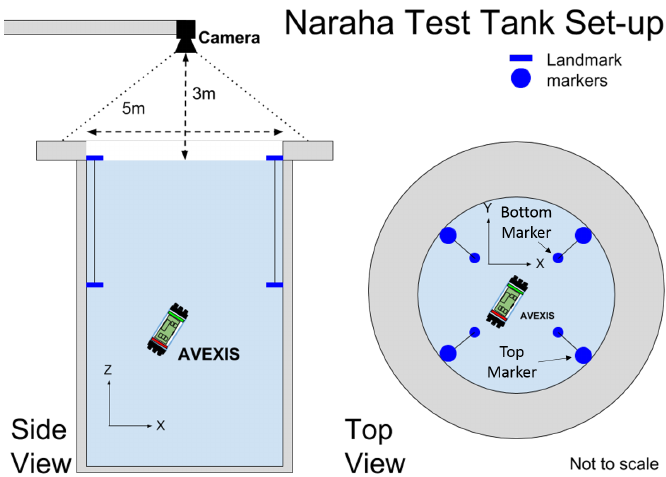
Figure 6. Example deployment of passive markers in the Naraha testing pool with the image localization system